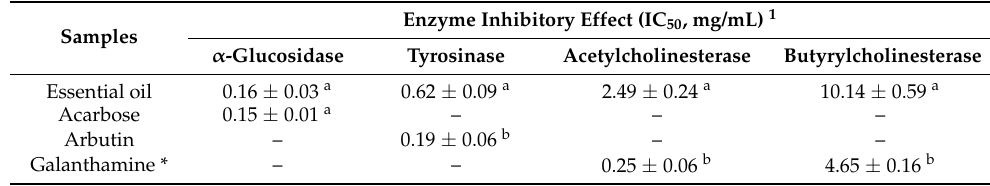
Table 4. The enzyme inhibitory activity of A. galanga flower essential oil.